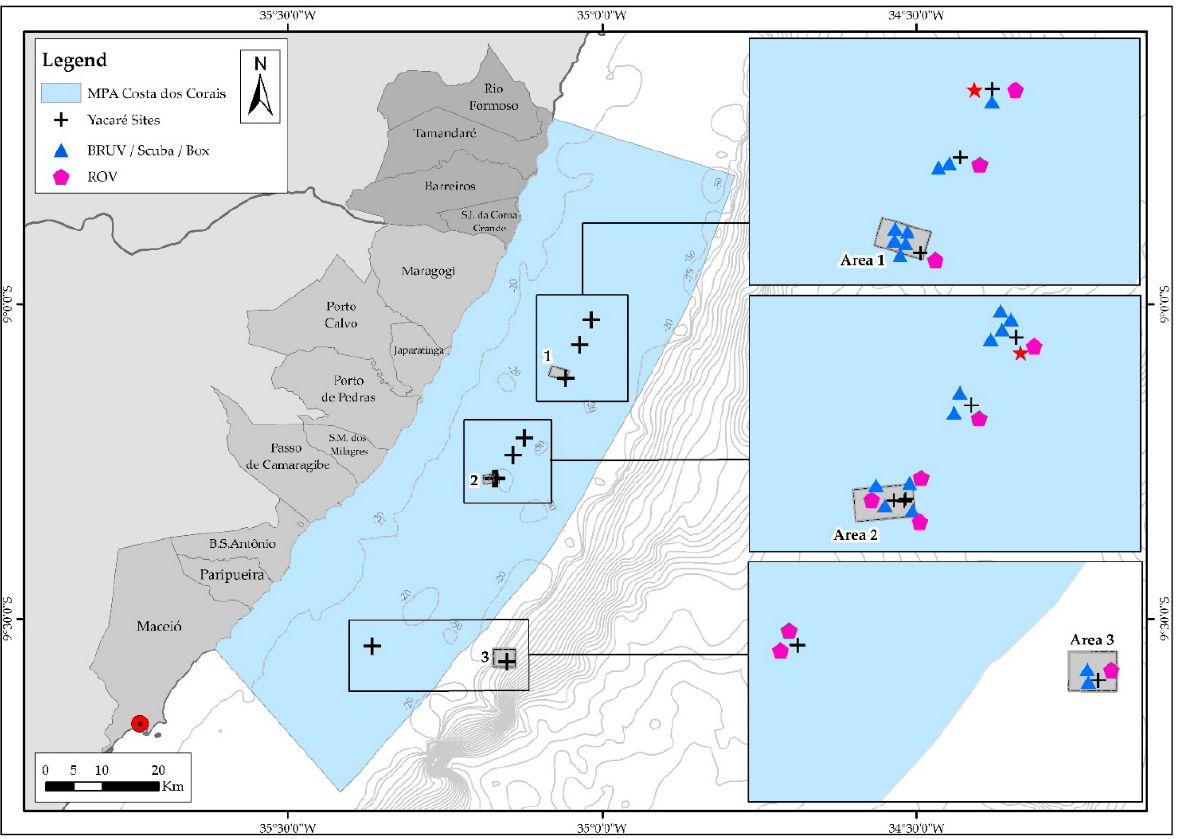
Figure 2. Experimental design with highlighted sampling areas and different methodologies implemented, such as the remotely operated underwater vehicle (ROV), baited remote underwater video (BRUV), and scuba diving.